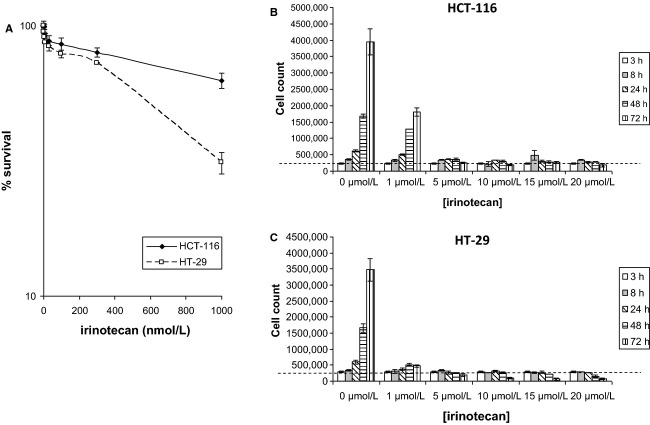
In vitro cell survival and proliferation data. (A) Cell survival curves for HCT-116 and HT-29 cells treated with irinotecan doses of 0, 1, 3, 10, 30, 100, 300, and 1000 nmol/L (±SE of the mean of three independent experiments) over 24 h as determined by clonogenic survival assay. (B) HCT-116 and (C) HT-29 cell counts (±SE of mean of three independent experiments) following 3, 8, 24, 48, and 72 h of irinotecan treatment at concentrations of 0, 1, 5, 10, 15, and 20 μmol/L. Broken line represents initial numbers of cells seeded – 200,000 cells per well.